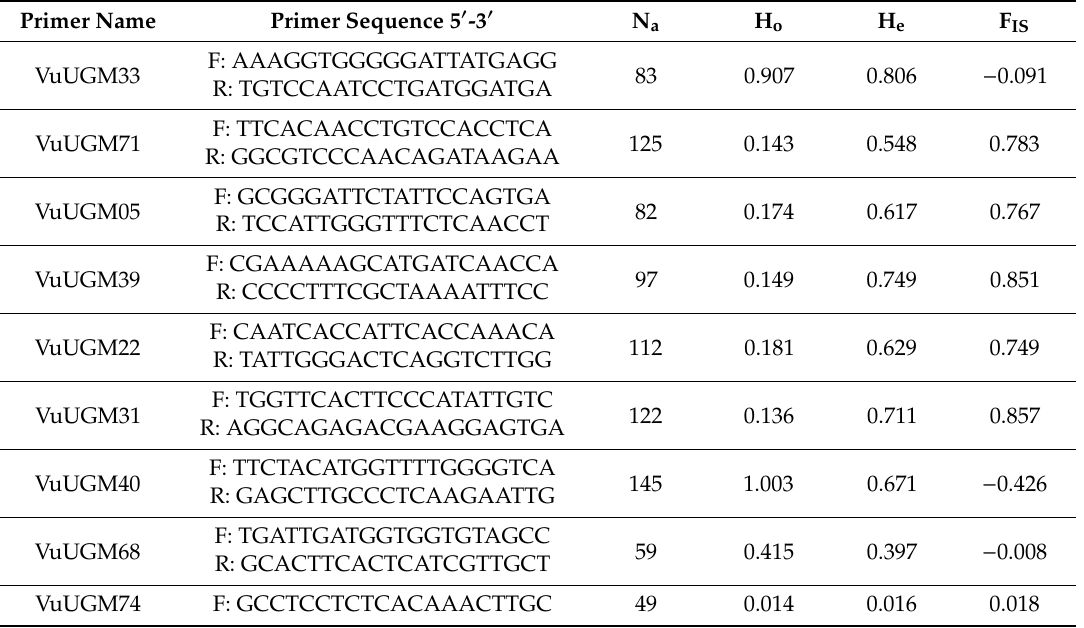
Table 1. Characteristics and genetic diversity statistics of the nuclear single sequence repeat (nSSR) primers used in the genetic study of Vigna unguiculata. For each locus, the total number of alleles (Na), mean expected heterozygosity (He), mean observed heterozygosity (Ho), and fixation index (FIS) obtained from the 61 studied samples are